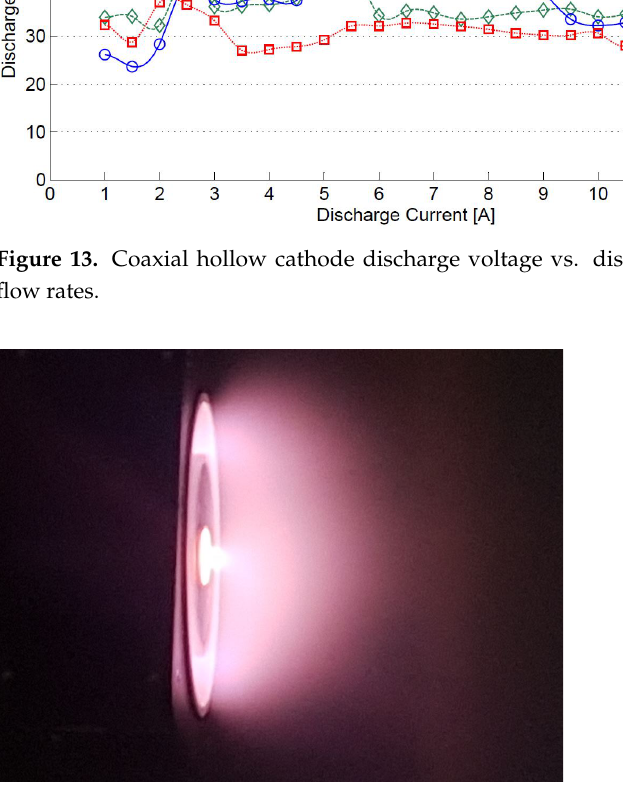
Figure 14. Novel coaxial–heater hollow cathode in internal cathode configuration with UK90 Hall thruster during